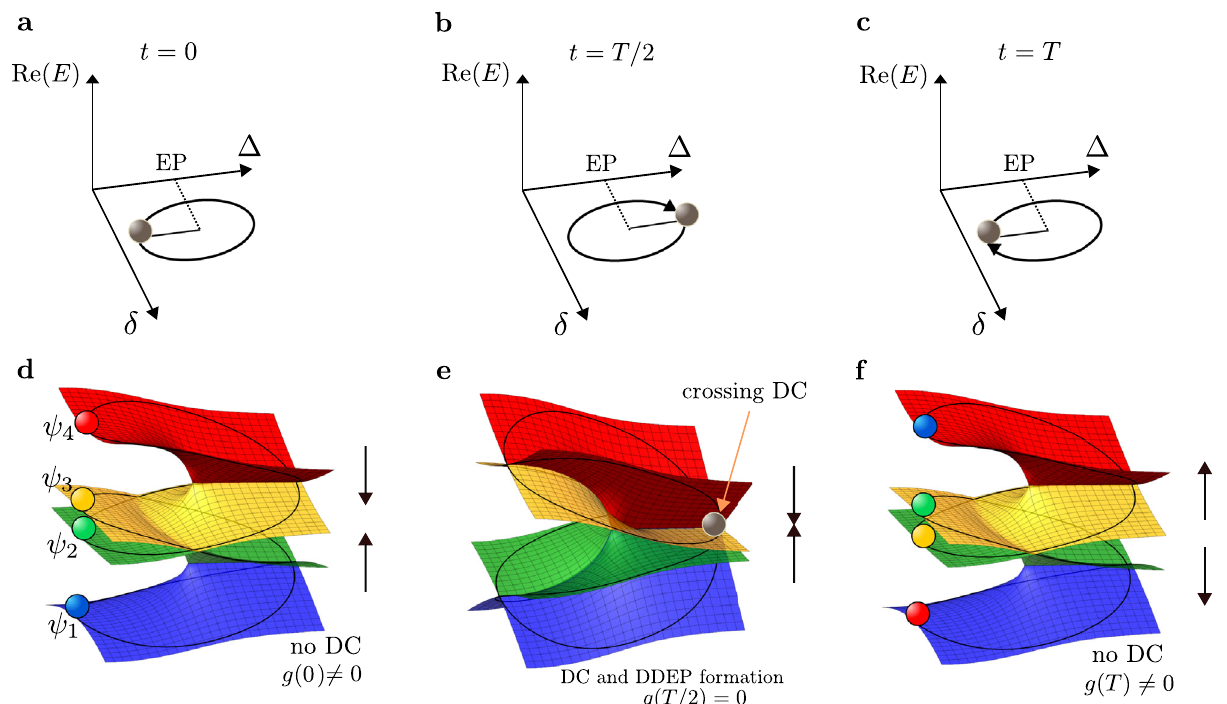
Fig.3|Encirclinganexceptionalcurve,EC,bycrossingadiaboliccurve,DC,ina four-mode system described by an NHH in Eq. (6). a – c The encircling trajectory projected on the 2D parameter space is de fi ned by the dissipation strength Δ and the perturbation δ at different stages of the encircling process. The vertical axis is the real-valued energy Re ð E Þ . The grey ball represents an evolving system eigen- mode. d – f Real-valued energy Riemann sheets at corresponding stages of the encirclingprocess,whoseaxisarethesameasinpanels a – c . a , d Initialstateat t =0: two separated exceptional points, EPs. At one of the EPs there is branch cut between the red and yellow Riemann sheets, and at the other EP there is a branch cut between the green and blue sheets. Four different eigenmodes ψ 1,2,3,4 are depicted ascolored balls. c , e When the encircling trajectory crosses the DC in the